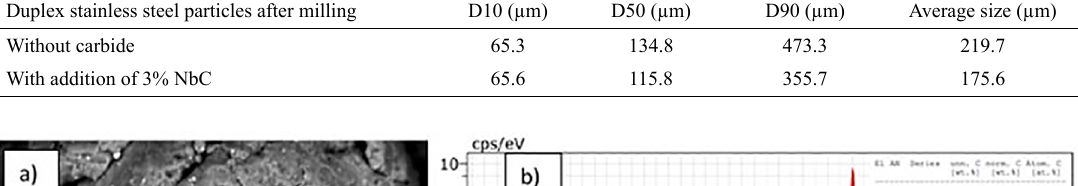
carbide niobium Nb and